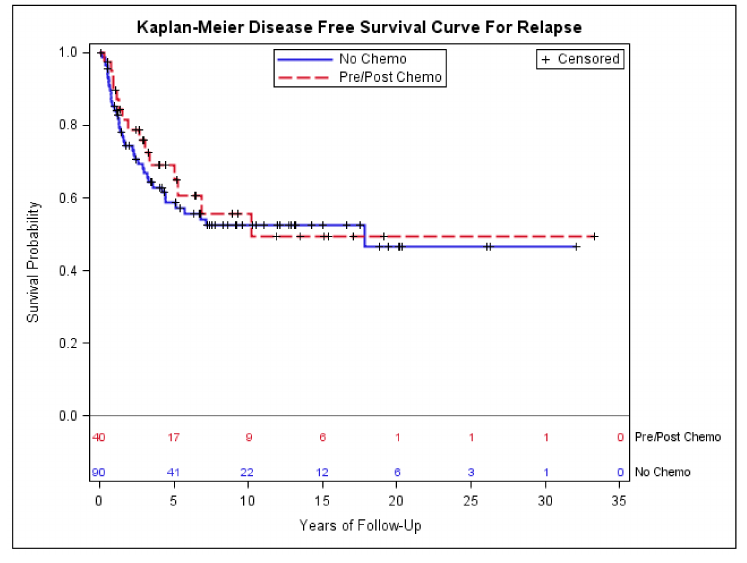
Figure 4. Kaplan–Meier estimates of disease-free survival of early-stage patients who did and did not receive